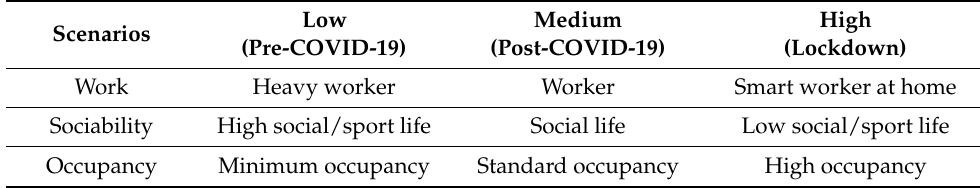
Table 2. Qualitative characterization of the analysed